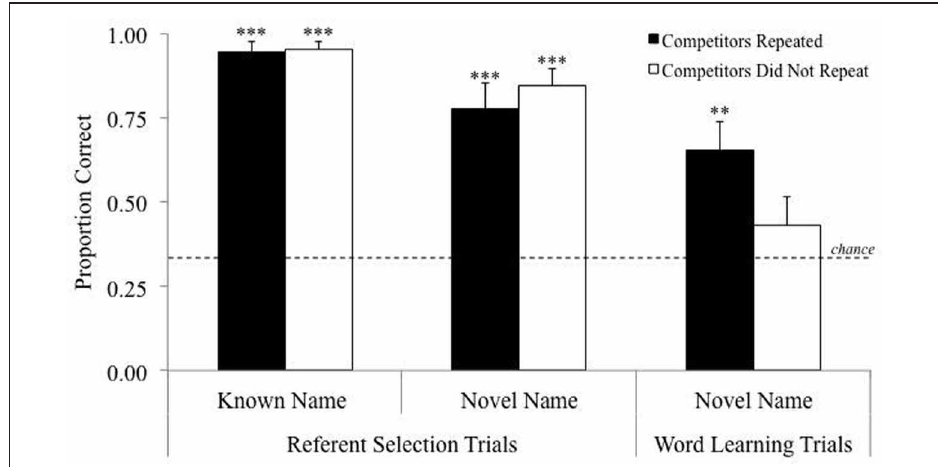
FIGURE 2 | Results from repeated competitors experiment. Dotted line represents chance (0.33). Error bars represent one standard error. ∗∗∗ p < 0 . 001, ∗∗ p < 0 . 01. All p s are